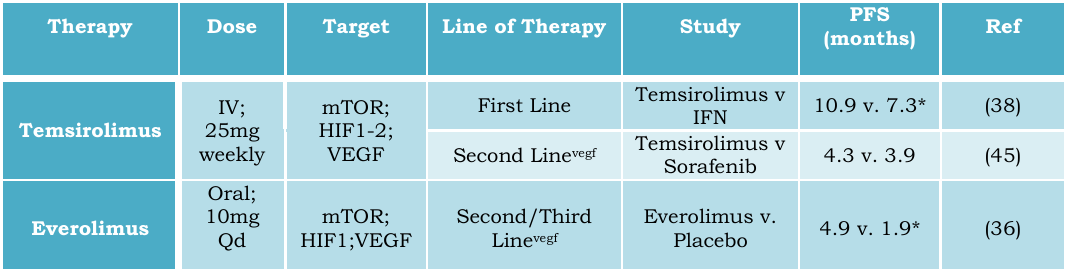
Table 2: m-TOR inhibitors: dose, molecular target and PFS outcome